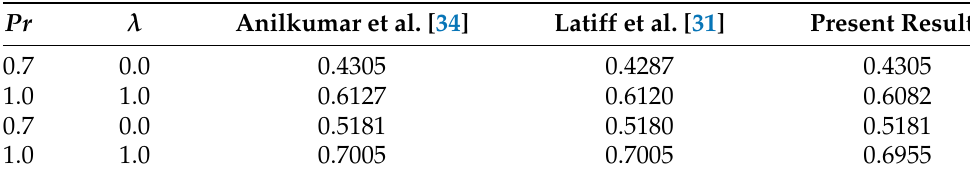
Table 1. For Pr and λ , comparative outputs of − θ (cid:48) ( 0 ) . Pr λ Anilkumar et al. [34] Latiff et al. [31] Present